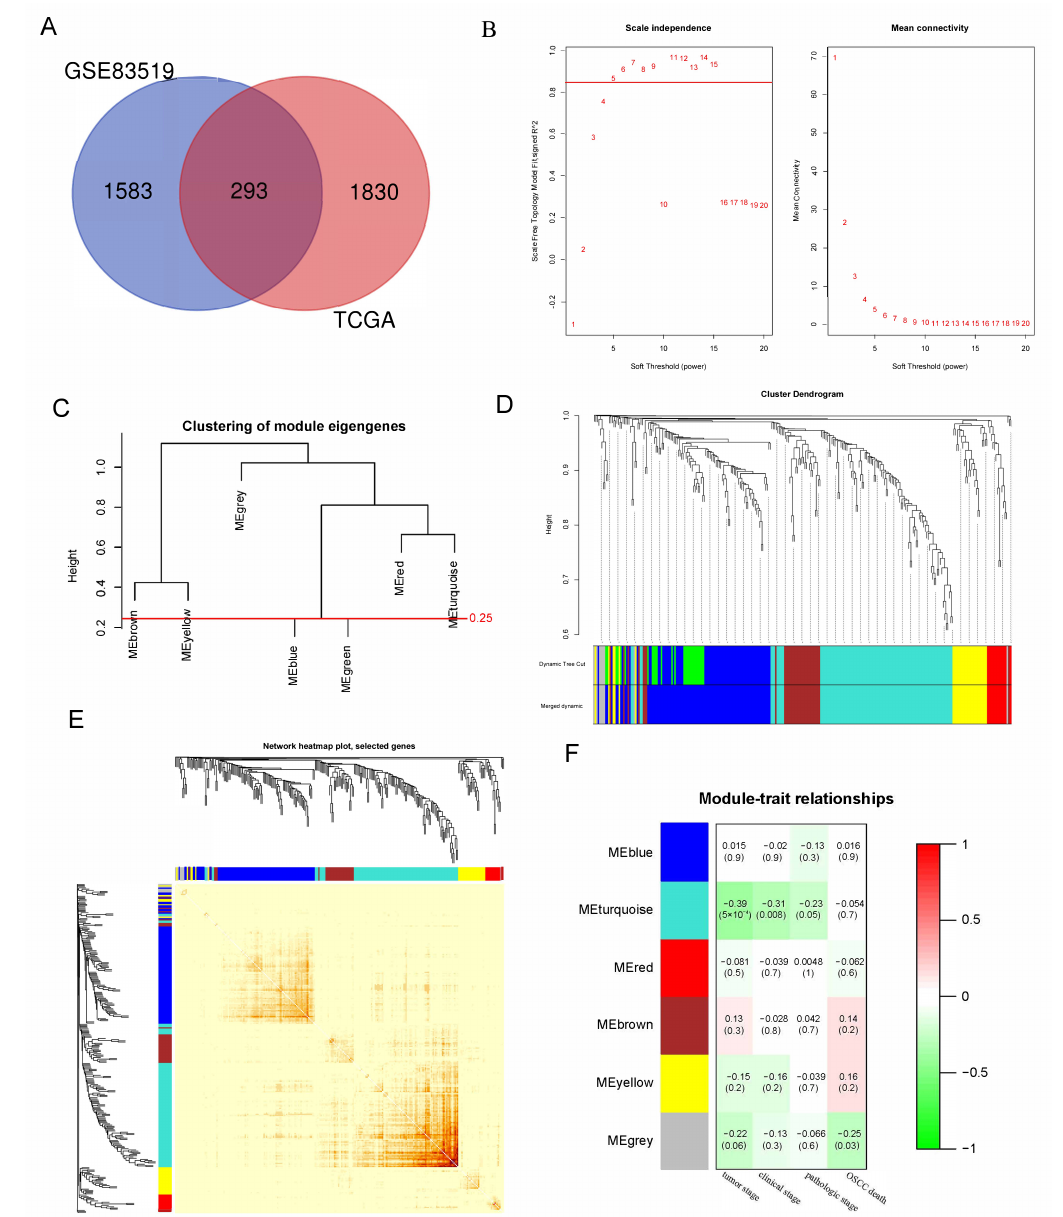
Figure 1. Identification of key modules correlated with clinical traits through WGCNA. ( A )Venn diagram shows the intersecting DEGs from GEO and TCGA. A total of 293 DEGs are shared by GSE83519 (blue) and TCGA-HNSC (red). ( B ) Analysis of the scale independence ( left ) and the mean connectivity ( right ) for different soft-thresholding powers. Five was set as the soft-thresholding power, meanwhile the scale free R2 was 0.87 > 0.85. ( C ) Clustering of module eigengenes. The cut height (0.25) was indicated by the red line. ( D ) Dendrogram of 278 DEGs clustered based on a dissimilarity measure (1-TOM), each module containing 10 genes at least. The merged dynamic contained six modules after combining the green and blue modules which were under the cut height (0.25). ( E ) Dendrogram and heatmap of DEGs. The color intensity varied positively with the correlation of different DEGs according to the topological overlap matrix (TOM). ( F ) Heatmap of the correlation between module eigengenes and clinical traits. The p value and module–trait correlation were contained in each